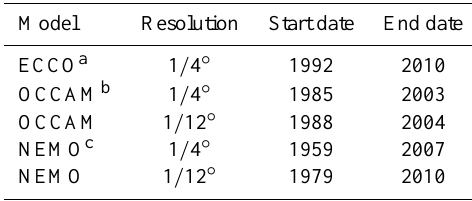
Table 1. Ocean circulation models used in this study.